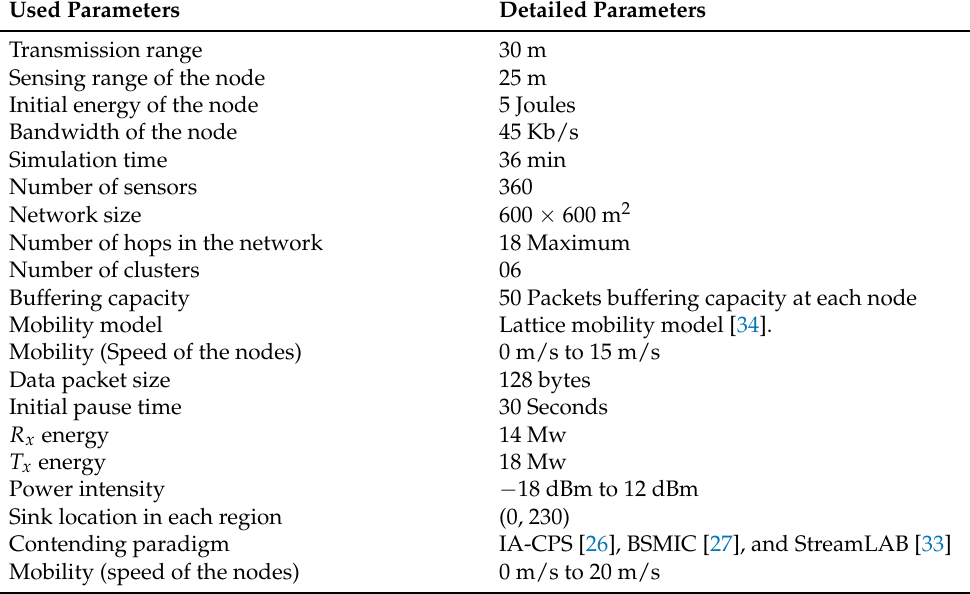
Table 2. Parameters in the simulation setup. Used